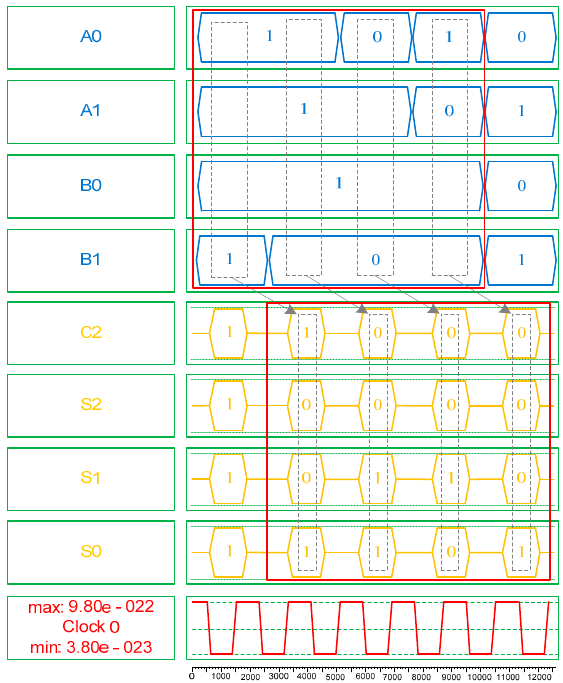
Table 3. Simulation parameters. Parameters